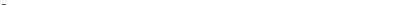
= 1 TeV and right panel σ